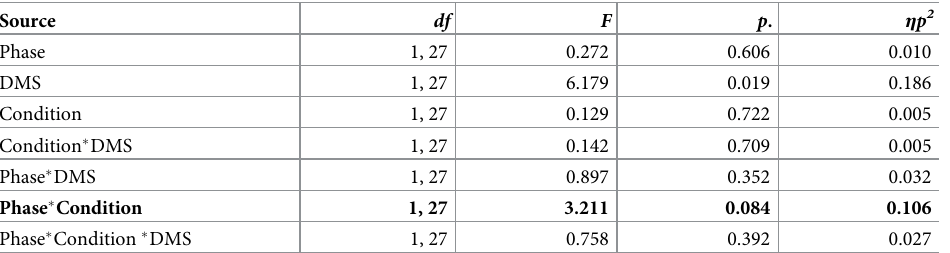
Table 8. Tabulated values for mixed ANOVA with phase (pre- versus post-manipulation preference for muscular- ity scores) as the repeated measures variable and condition as the between-participants factor and DMS as a covar- iate for male data. Critical tests of our hypotheses are shown in